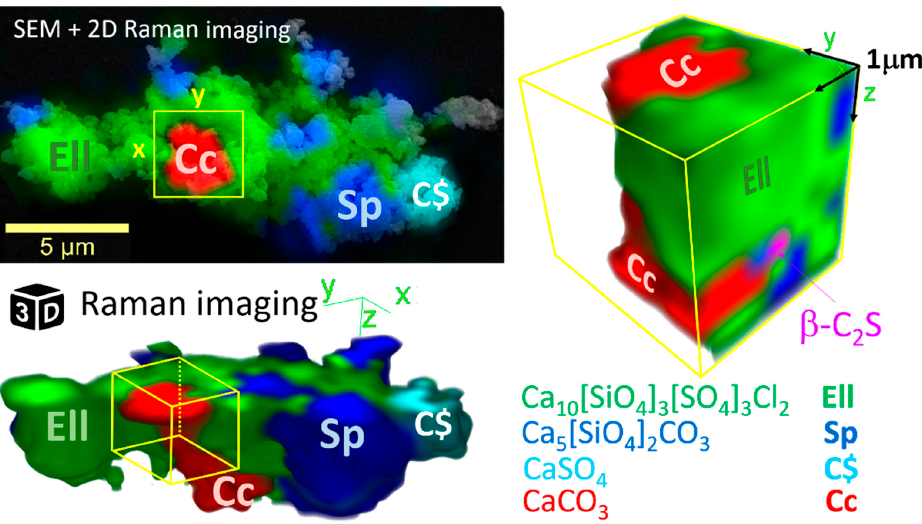
Figure 11. Top: overlay of an electron micrograph (SE) of an aggregate of sample D2 calcined at 800 °C with a corresponding Raman image of the phase distribution in false colors (red: calcite; blue: spurrite; green: ellestadite; light blue: anhydrite C$). Bottom: a 3D image of the same aggregate (same color scheme). Right: clipped 3D image of the cube marked as a yellow cube (rotated at 90°). Presence of β -C 2 S crystal (purple) formed at the interface between spurrite (Sp), ellestadite (Ell), and calcite (Cc).